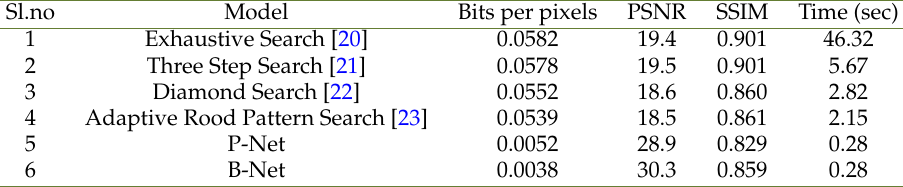
Table 3. Motion compensation value for macroblock split 8X8 with pixel around the block as 7 for16 frame video prediction.